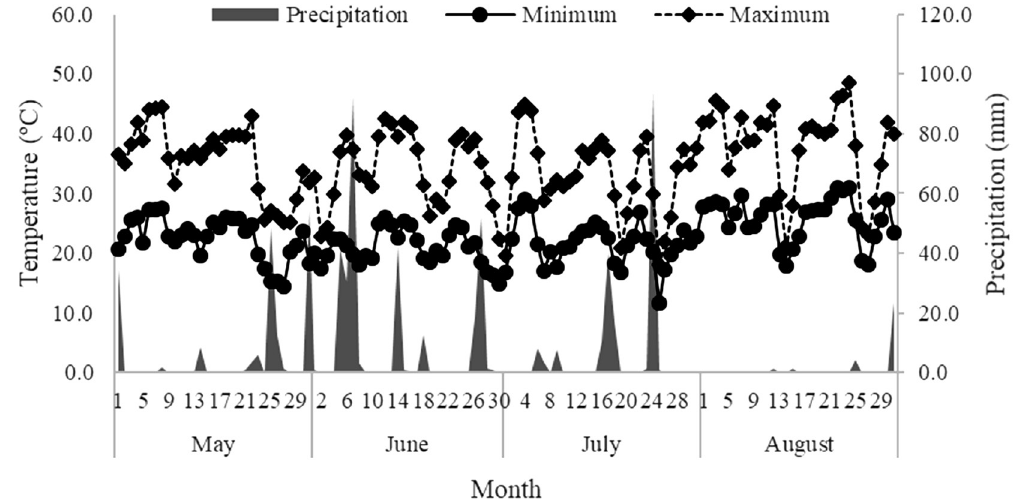
Figure 1. Rainfall and temperature (maximum and minimum) in Dois Vizinhos, Paraná, from May to August 2014, GEBIOMET